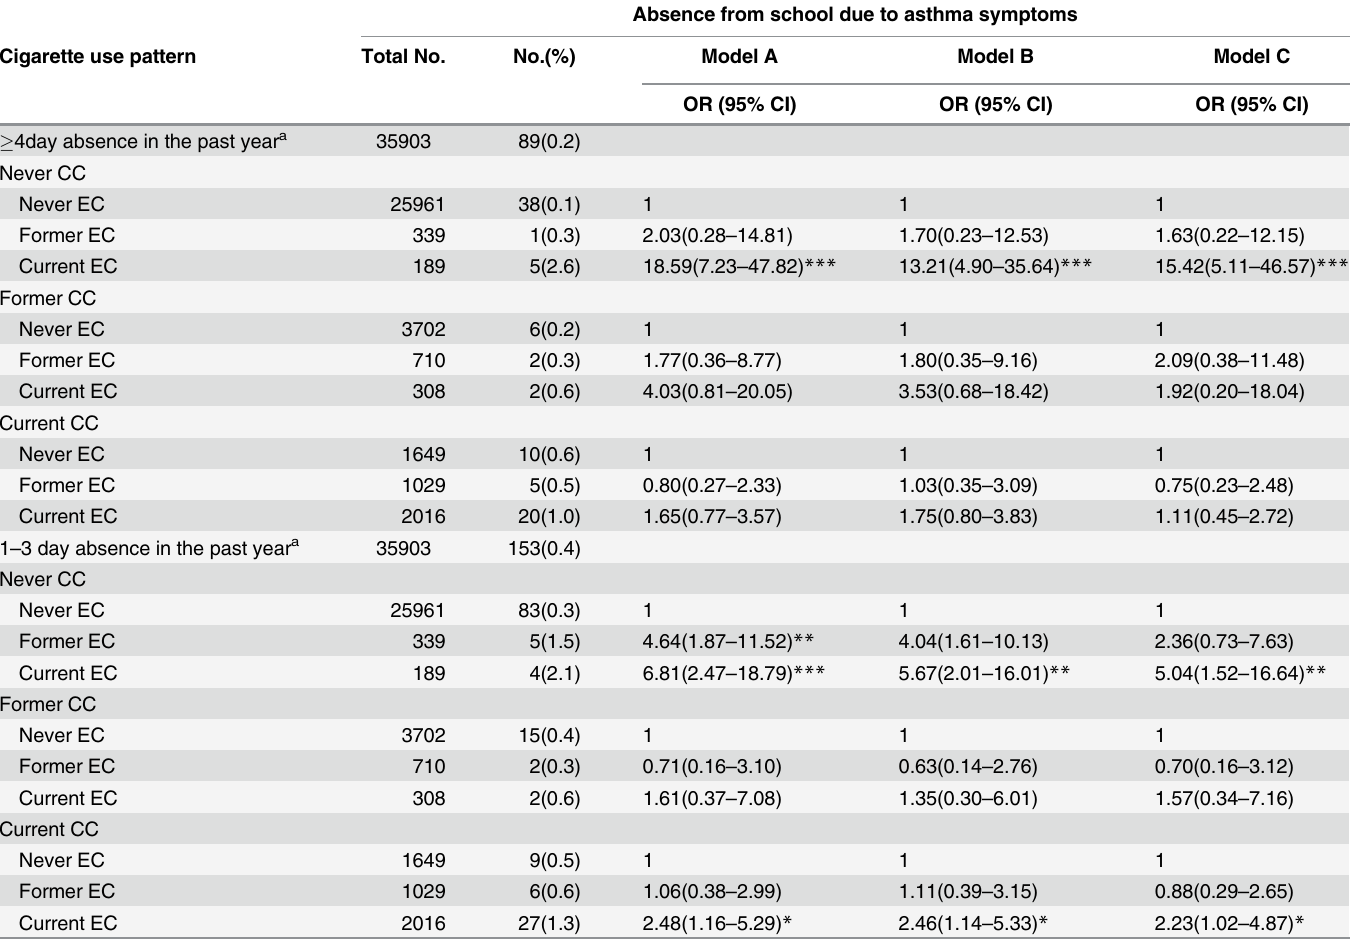
Table 7. Results of multi-nominal logistic regression analyses on the frequency of students ’ absence from school for asthma. Absence from school due to asthma symptoms Cigarette use pattern Total